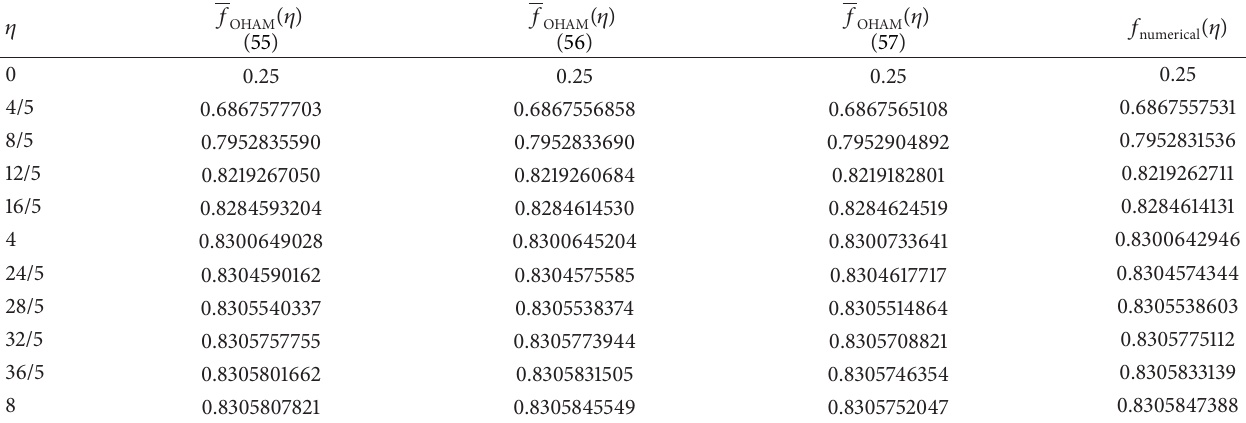
Table 4: Comparison of the first-order approximate solution 𝑓 obtained by OHAM with numerical results.